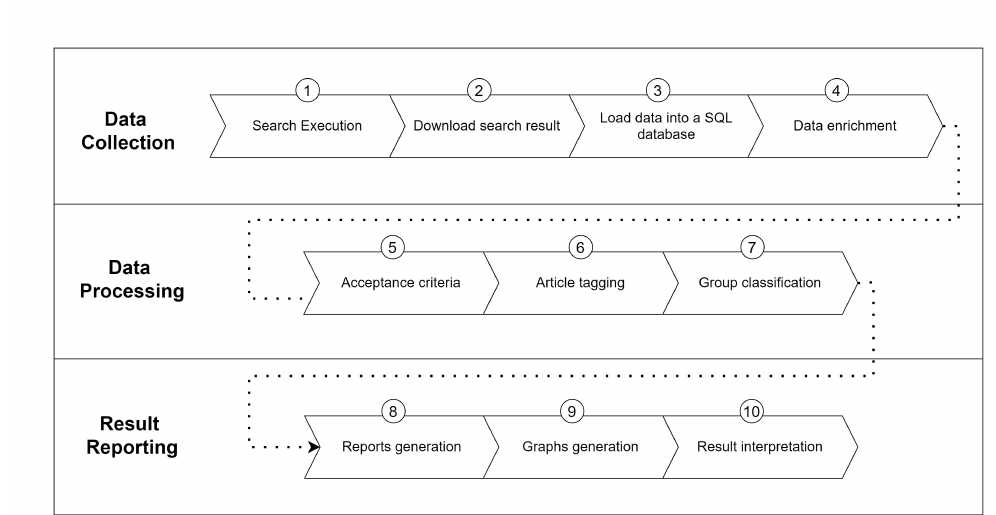
Figure 10. Steps of the processing